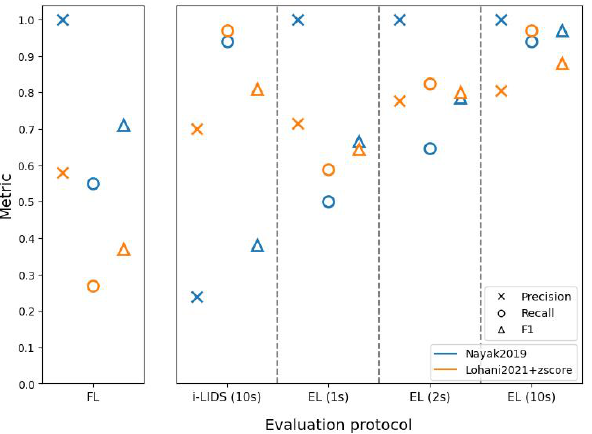
Figure A2. The results of two methods: [47] (in blue) and [6] with z-score (in orange), tested on view 2 of i-LIDS test set with intruder at mid distance from camera. The abscissa represents three evaluation protocols: frame-level (FL) (on left subfigure), i-LIDS and edge-level (EL) (on right subfigure). i-LIDS is evaluated by default for 10 s whereas, for EL, we show results for 1, 2 and 10 s. The ordinate represents values of three metrics: precision, recall and F 1 score.